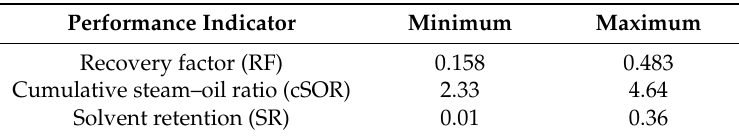
Table 3. Maximum and minimum values obtained from 100 simulation results used for training proxy